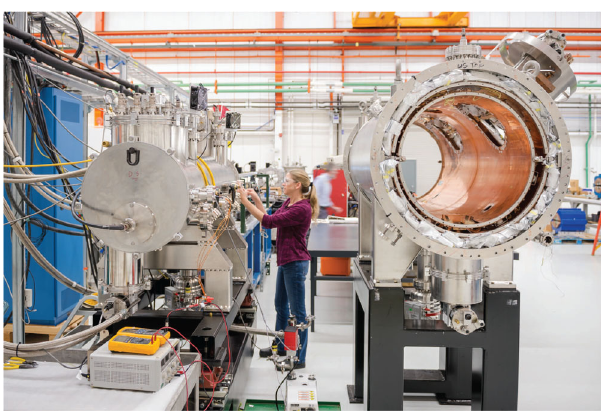
FIG. 19. Side by side comparison of the 1st and 2nd generation cryostats.